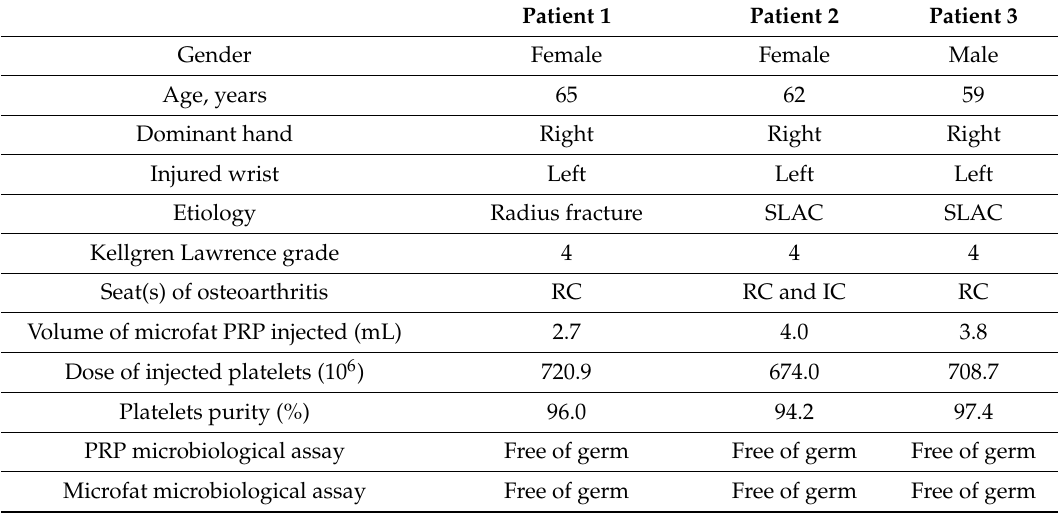
Table 2. Patients and injected products characteristics obtained from the first three patients treated with microfat-PRP ATMP.